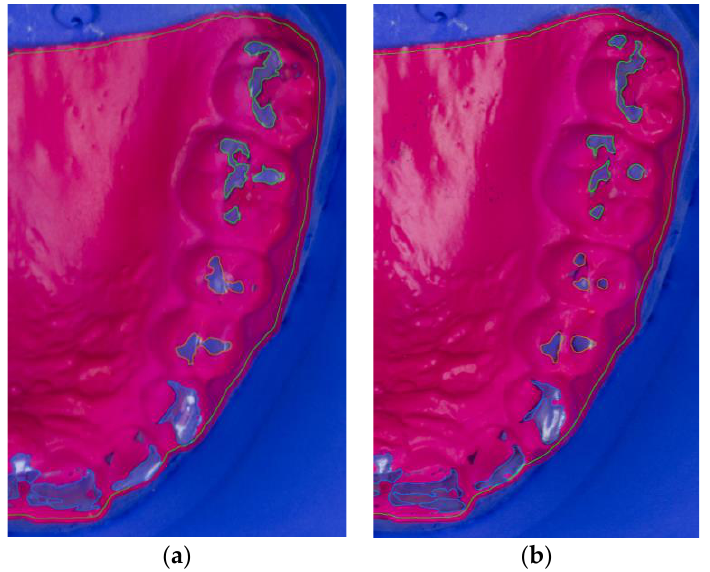
Figure 2. Segmented photograph (zoomed in) of BruxChecker ® foil after wear ( a ) “stress” phase; ( b ) “consecutive” phase .